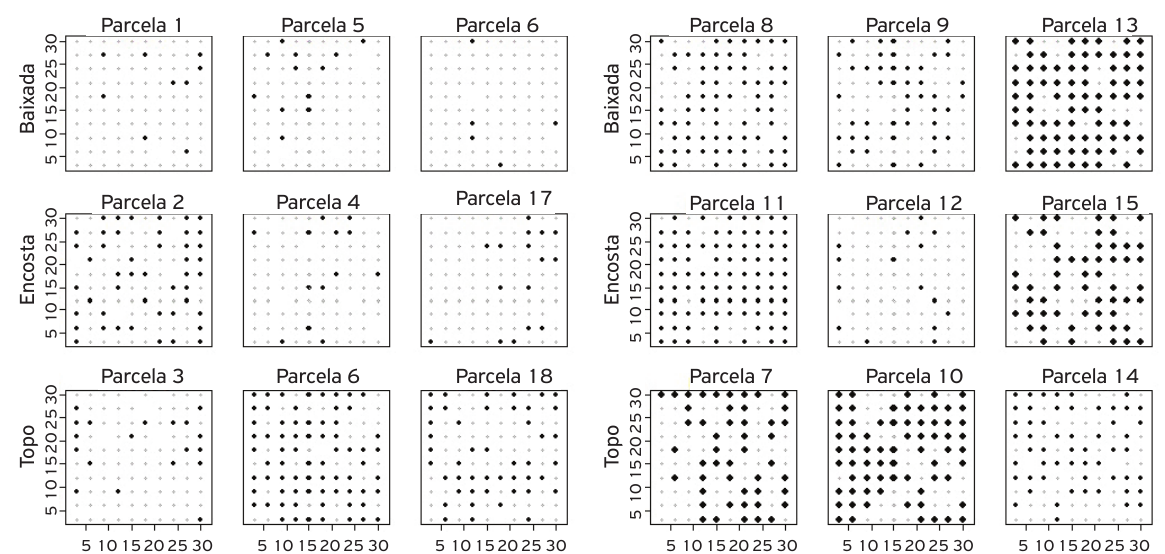
Figura 3. Distribuição do ataque de Heilipodus naevulus (Mannerheim, 1836) em áreas de plantio de clones de eucalipto, arranjo sob espacial de 3 x 3 m, no mês de novembro /2008, nos talhões 21 (7 – 12, 16 – 18) e 29 (1 – 6, 13 – 15), subdivididos em baixada, encosta e topo. Barão de Cocais (MG).